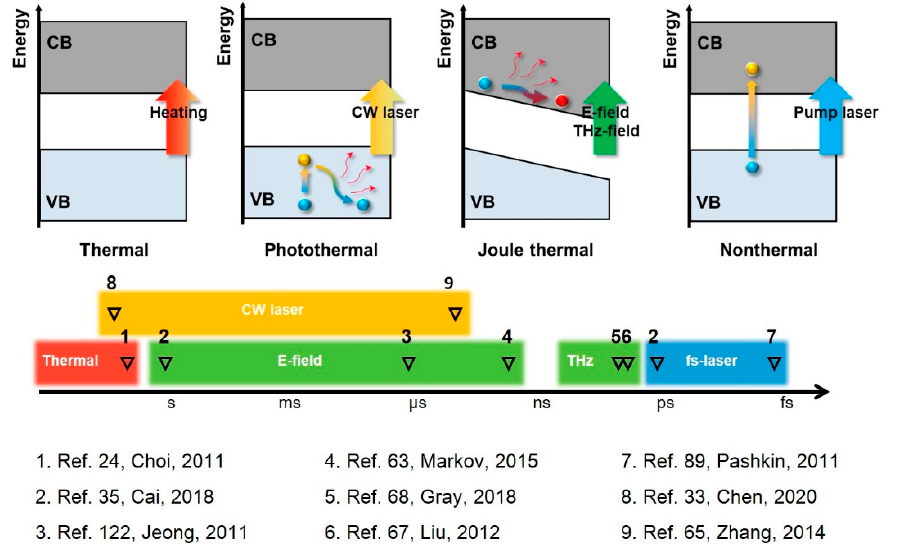
Figure 15. Overview of the available modulation schemes for VO 2 -based optical devices in the THz regime: Modulation approaches based on heating (red arrow), CW laser (yellow arrow), electric field and intense THz field (green arrow) and pump fs laser (blue arrow), with thermal, photo89thermal, Joule thermal and direct photoexcitation (nonthermal) mechanism. The range of response time of the diverse modulation approaches are plotted as red, yellow, green and blue bars with experiment data presented as black triangles. The data are adapted from [24,33,35,63,65,67,68,89,122].